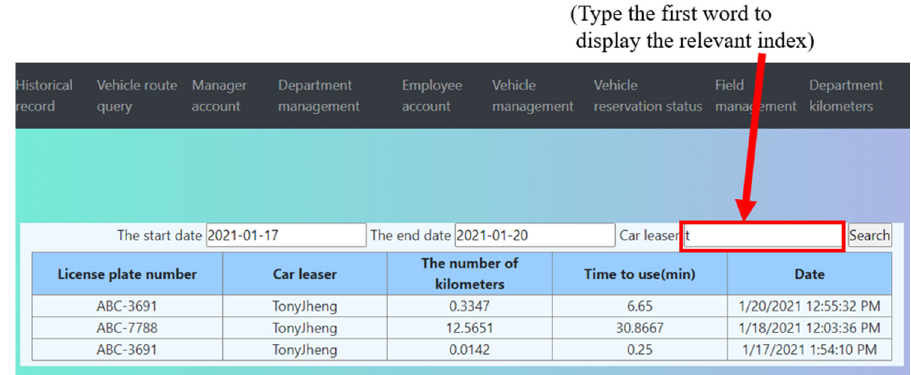
Figure 35. Back-end history query.